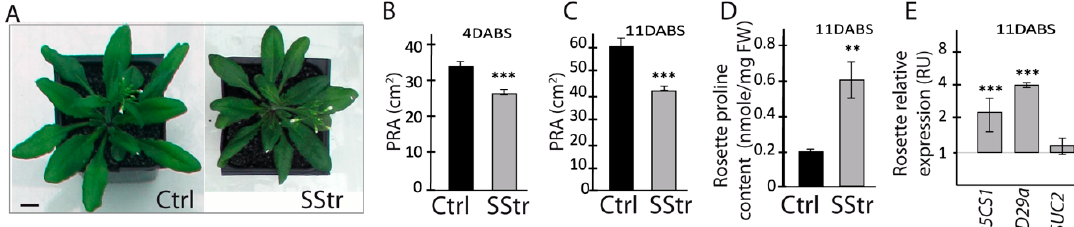
Figure 1. Effect of salt stress on rosette leaves: their growth and the expression of several stress markers. ( A ) Rosette growth at 4 days after the beginning of salt treatment ( DABS ) under control (Ctrl) and salt-stress (SStr) treatments. Bar: 1 cm ( B – C ) Projected rosette area in Ctrl and SStr plants at 4 DABS ( B ) or 11 DABS (C) ( n ≥ 10 and n = 6, respectively at 4 and 11 DABS). ( D ) Proline content in the rosette mature leaves in Ctrl and SStr plants at 11 DABS ( n ≥ 5). ( E ) Relative expression of P5CS1, RD29a and SUC2 in the rosette mature leaves in Ctrl and SStr plants at 11 DABS. RU: relative unit. The accumulation of mRNA for each gene in response to salt stress was normalized by the mean value of Ctrl plants ( n = 4–6) and expression data are shown on a log2 scale. Values represent means ± SE , in Ctrl (black bar) and SStr plants (grey bars). Asterisks indicate significant difference of treatments compared to control plants ( ** p < 0.01; *** p < 0.001).